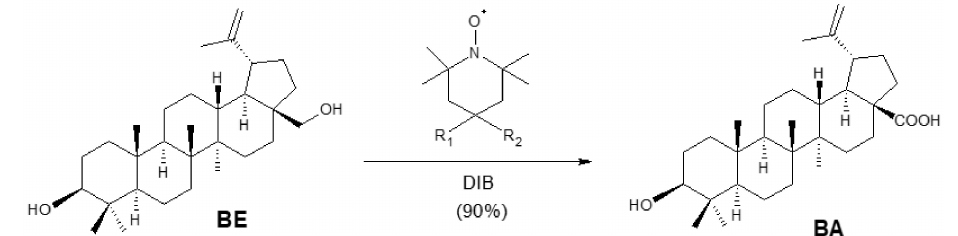
Scheme 5. Synthesis of BA from BE via TEMPO-type